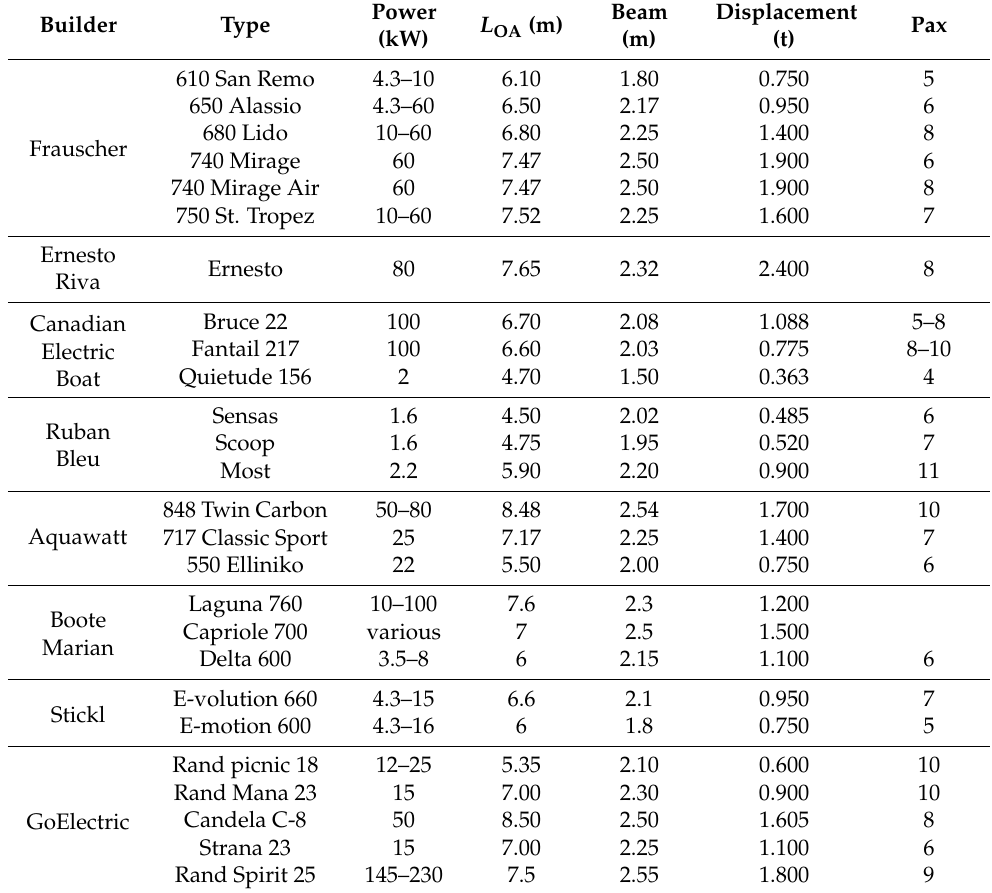
Table 1. Database of zero-emission small pleasure craft.